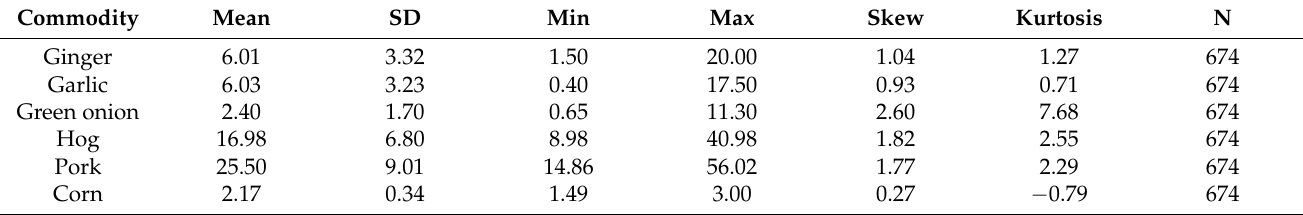
Table 1. Descriptive statistical analysis of agricultural commodity